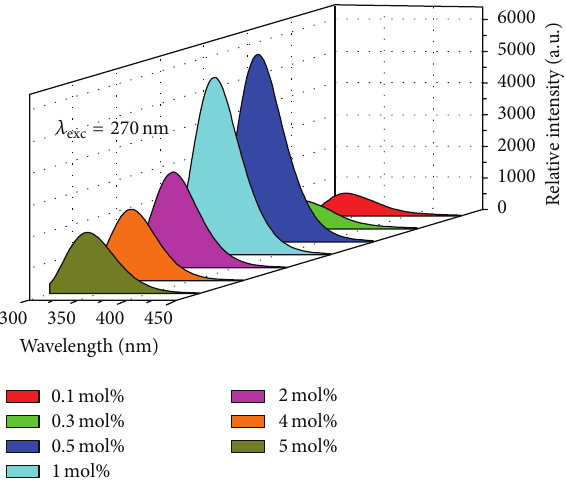
Figure 7: Variation in emission intensity of ( Ca (1−𝑥) Pb 𝑥 ) = 0.001, 0.003, 0.005, 0.01, 0.02, 0.03, (BO 3 ) 2 ( 𝑥 = 0.001, 3